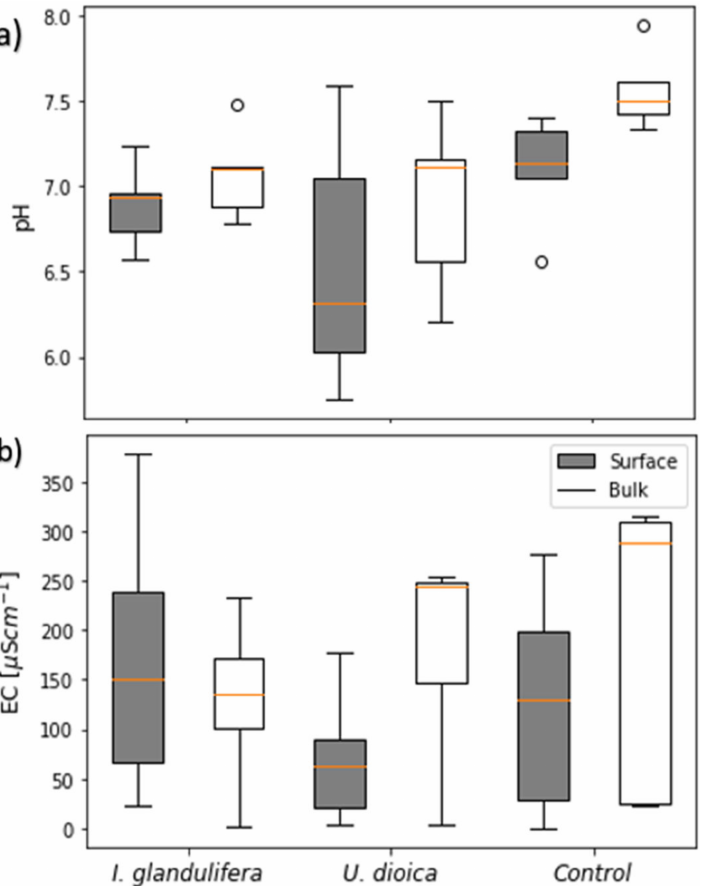
Figure 4. Physico-chemical soil parameters ( a ) pH value, and ( b ) electrical conductivity (EC) in µ S cm − 1 for surface (0–2 cm) and bulk layers (2–5 cm depth) of soil colonized by Impatiens glandulifera ( I. glandulifera ) and by Urtica dioica ( U. doica ) or of bare soil (Control). The boxes present the lower and upper 25th percentiles with whiskers showing the 1.5 fold interquartiles range (IQR) and all data points outside the 1.5 fold IQR depicted as empty